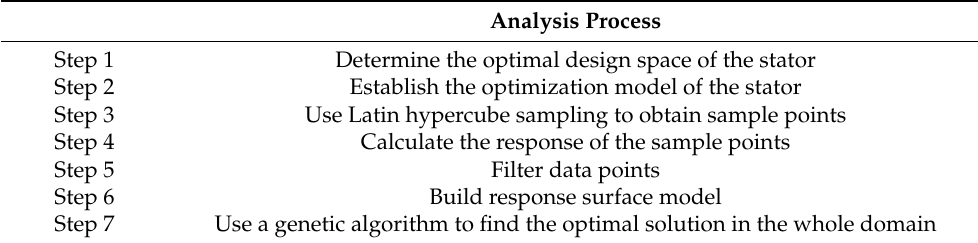
Table 1. Optimization analysis process.